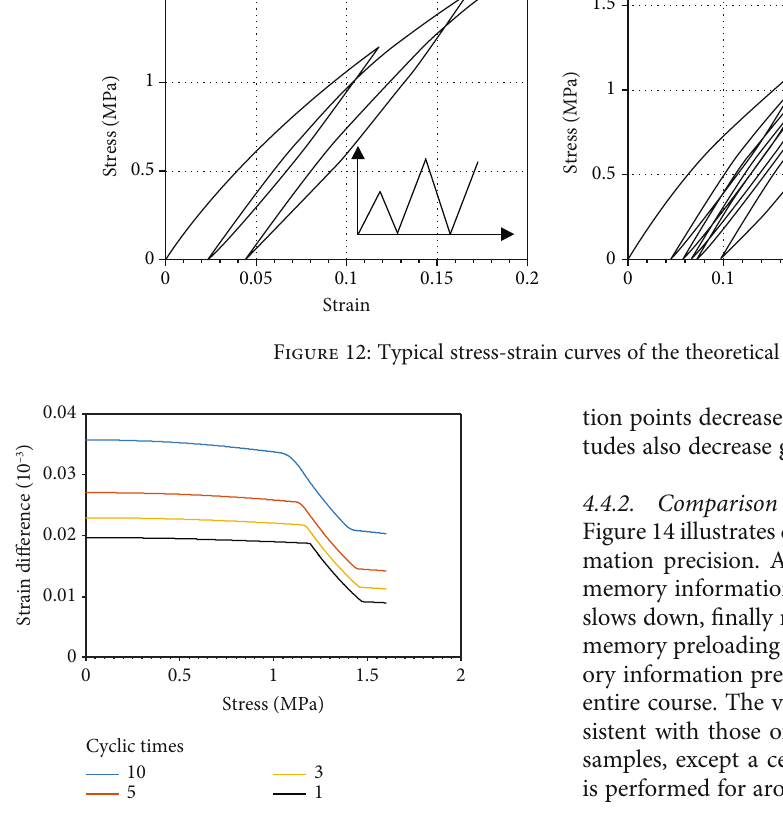
Figure 13: Typical DRA curves of the theoretical model under di ff erent cyclic